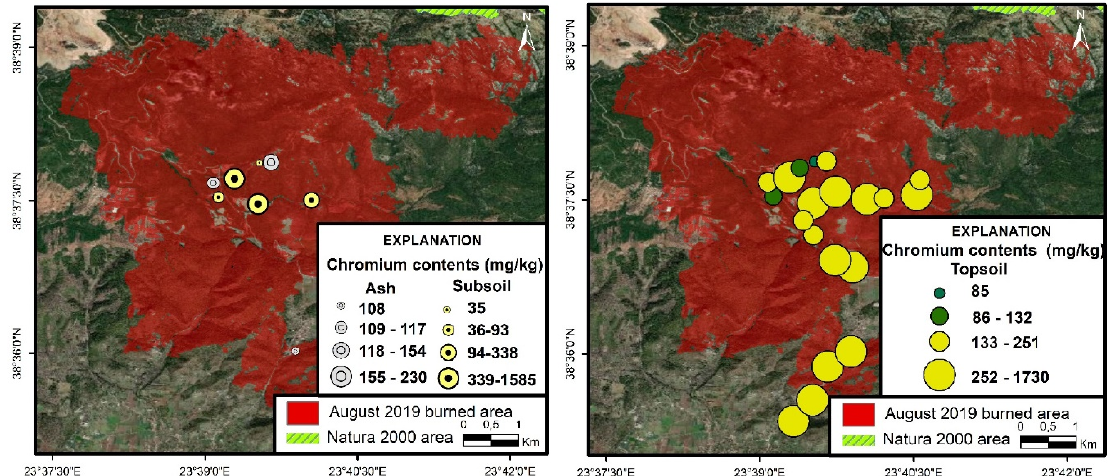
Figure 5. Map showing chromium contents in ash, topsoil and subsoil at the area studied (modified from [23,24,26]).